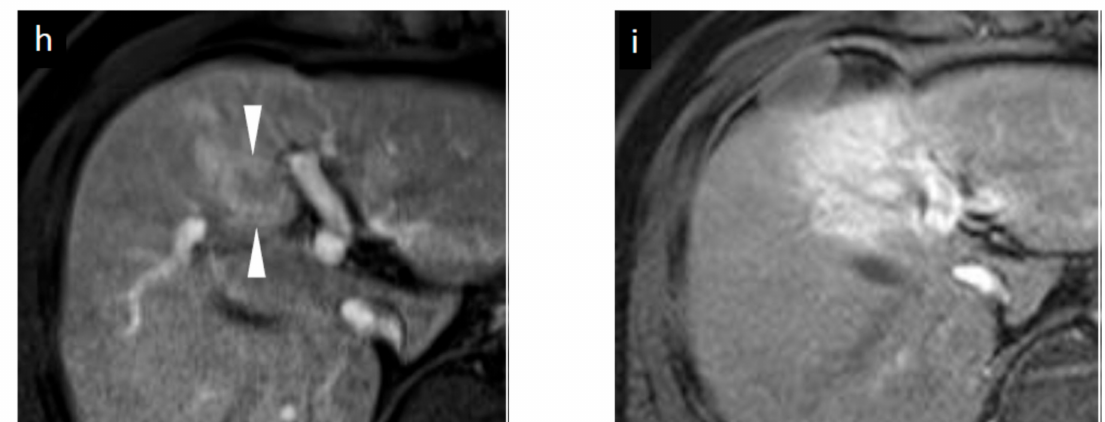
Figure 2. Grayscale ultrasound (US), contrast-enhanced US with Sonazoid (SCEUS), and contrast-enhanced MRI (CEMRI) images before and seven months after radiotherapy (RT) for a HCC lesion (maximum diameter: 22 mm) in segment IV, evaluated as no local recurrence after RT. A safe punctuation was difficult, as the lesion was located behind the gallbladder. The patient refused surgical resection, so they received RT. SCEUS before RT ( a – c ): A hypoechoic lesion was observed using grayscale US ( a ). This lesion showed hypervascularity during the arterial phase (AP) of SCEUS ( b ) and hypoechoic (perfusion defect) during the post vascular phase (PVP) ( c ). SCEUS seven months after RT ( d – g ): Grayscale US showed a hypoechoic nodule and a reduction in tumor size ( d ). AP SCEUS showed a disappearance of vascularity of the HCC lesion and hypervascularity of the surrounding liver parenchyma ( e ). Both the HCC lesion and the surrounding liver parenchyma appeared as a perfusion defect during the PVP ( f ). After re-injection of Sonazoid during the PVP, the HCC showed hypovascularity and the surrounding liver parenchyma showed hypervascularity ( g ). AP CEMRI before ( h ) and seven months ( i ) after RT: Before RT, this lesion showed hyperintensity during AP CEMRI ( h ). Both the HCC lesion and the surrounding liver parenchyma appeared as hyperintensity at seven months after RT ( i ). Seven months after RT, we observed a discrepancy between the vascularity shown by SCEUS and that by CEMRI, but the lesion has not recurred for more than 3 years, suggesting that the SCEUS findings might be correct. Arrowheads show the margins of the HCC lesion. Arrows show the margins of irradiated surrounding liver